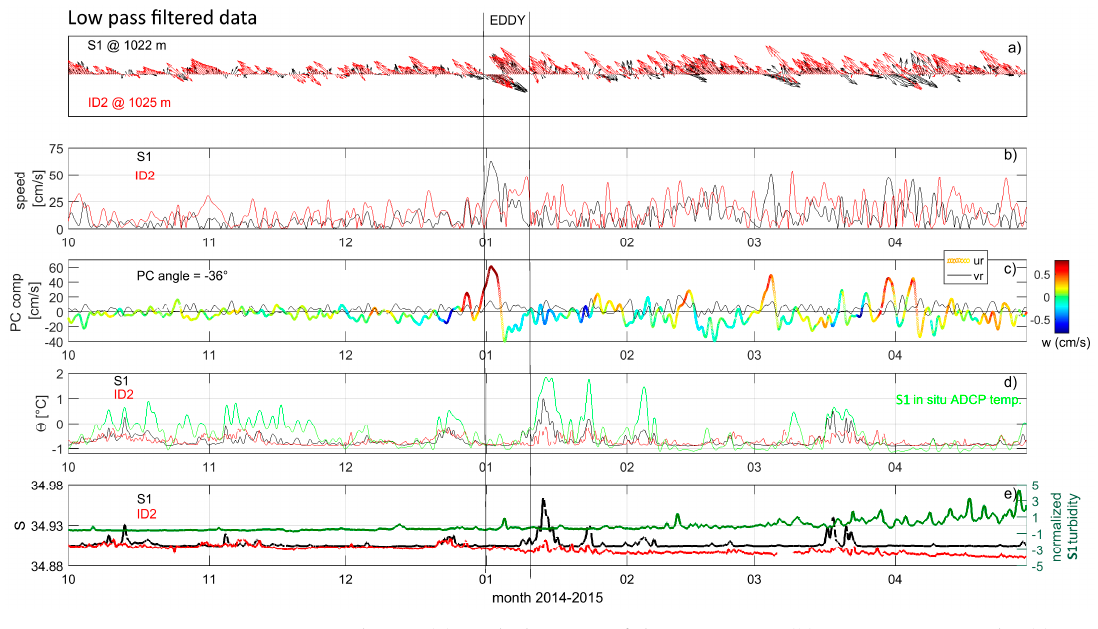
Figure 7. Time series at S1 and ID2. ( a ) Stick diagram of deep currents; ( b ) current magnitude; ( c ) current component along the direction of maximum variance at S1 (1017 m depth, ur positive towards SE); the colorbar refers to vertical velocity ( w ) from the ADCP at the same depth. The angle of maximum variance is referred to the trigonometric system; ( d , e ) θ and S at 1017 m (S1) and 1025 m (ID2) depth. Temperature (T) from the ADCP at 909 m and turbidity are also shown (green lines in panels d and e). Data refer to the period 1 October 2014–30 April 2015.